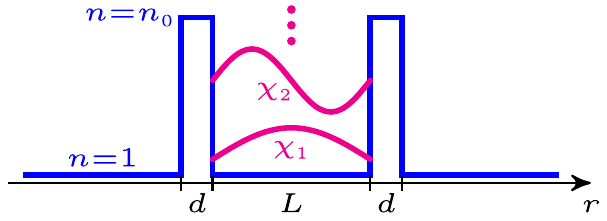
FIG. 4. Model potential with two barriers. In the Maxwell case, this model corresponds to the Ley-Loudon model for a two-sided Fabry-Perot cavity [101], and the solid blue curve shows the spatial refractive index distribution. For simplicity, in the calcu- lation, the thin-mirror limit d → 0 is considered, with n 0 → ∞ such that η ¼ n 2 0 d remains finite [95,101]. In the cavity, the first two perfect-cavity modes χ 1 and χ 2 are shown as magenta curves. For the Schrödinger case, the solid blue curve indicates the potential energy, which defines a tunneling